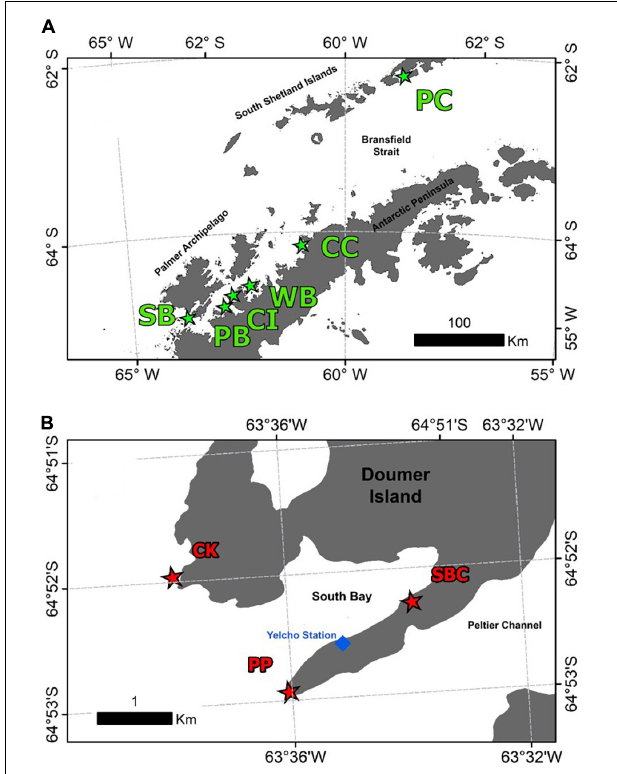
FIGURE 1 | Map of the sites where samples of the Antarctic sponge M. acerata were collected along the WAP (A) and sampling was conducted at a finer scale in (B) South Bay (SB), Doumer Island. In grey, the Antarctic Peninsula and Islands; in white, the Southern Ocean. The sites are as follows: PC, Potter Cove; CC, Cierva Cove; WB, Wilhelmina Bay; CC, Cuverville Island; PB, Paradise Bay; SB, South Bay. Sites sampled in South Bay, Doumer Island (B) , SBC, South Bay coast; CK, Cape Kemp; PP, Py Point. Map constructed using Gerrish et al. (2020) High resolution vector polygons of the Antarctic coastline (7.3) (Data set). UK Polar Data Centre, Natural Environment Research Council, UK Research and Innovation